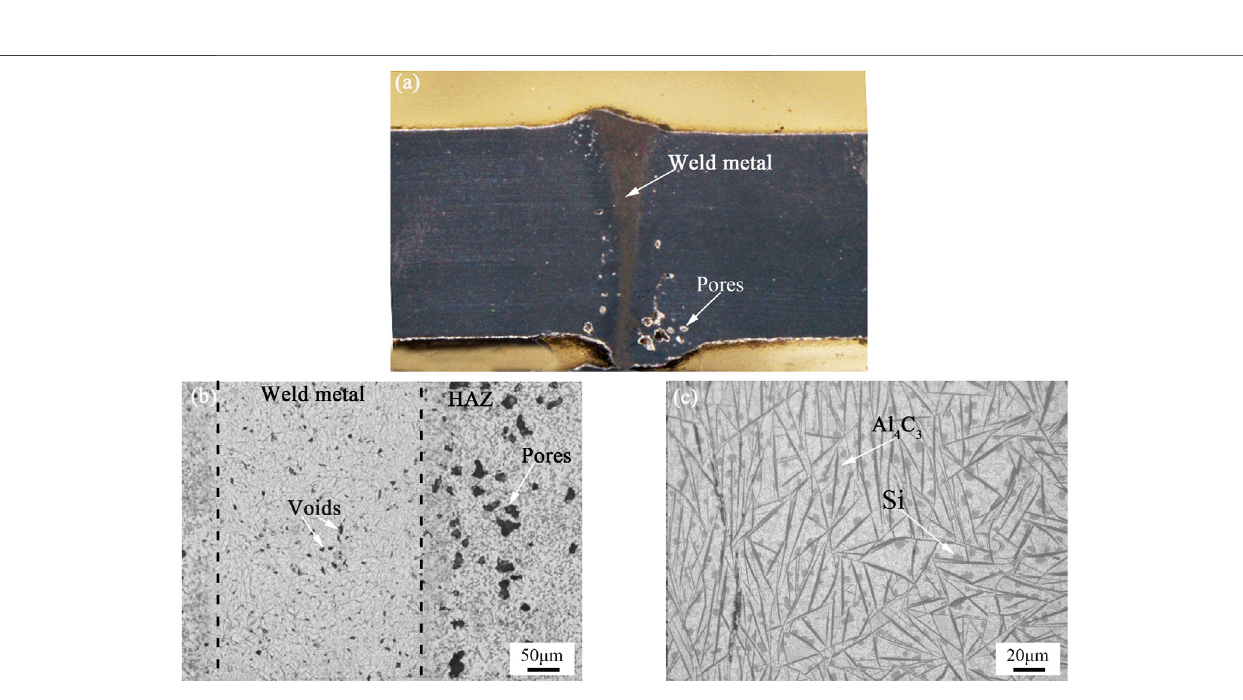
Frontiers in Materials |